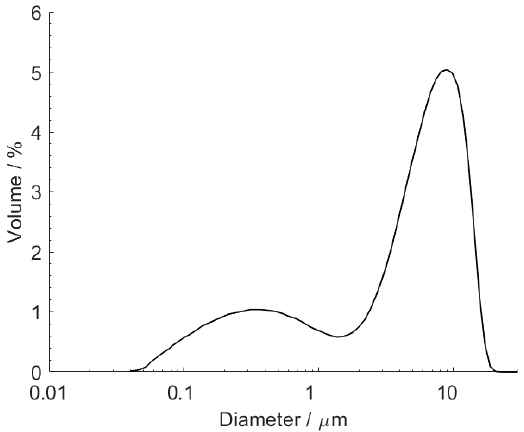
Figure 3. Cross-section of LDPE sample containing 1.5 wt.% MHP, cut with blade, showing that the particles were undamaged by processing and are uniformly distributed within the LDPE sample (magnification: ( a ) 930x).